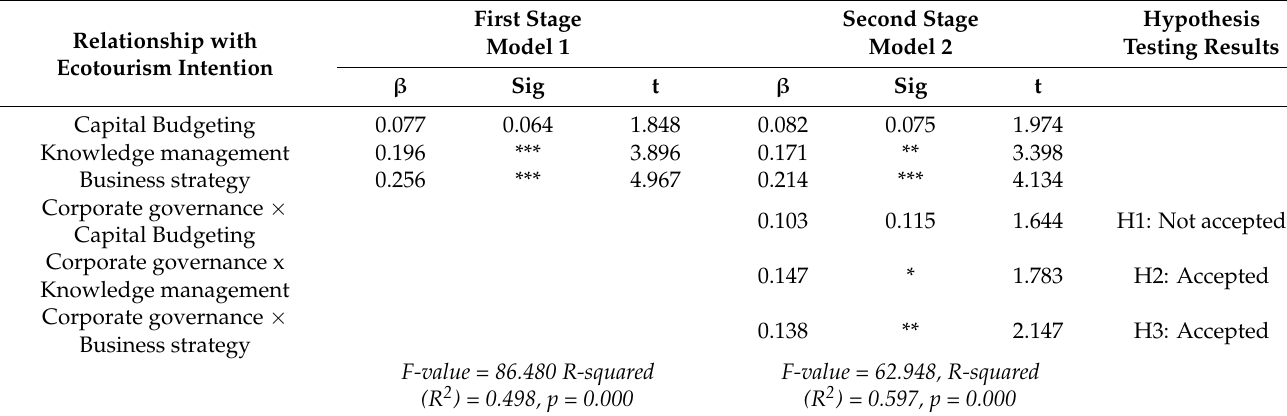
Table 4. Results of hierarchical regression